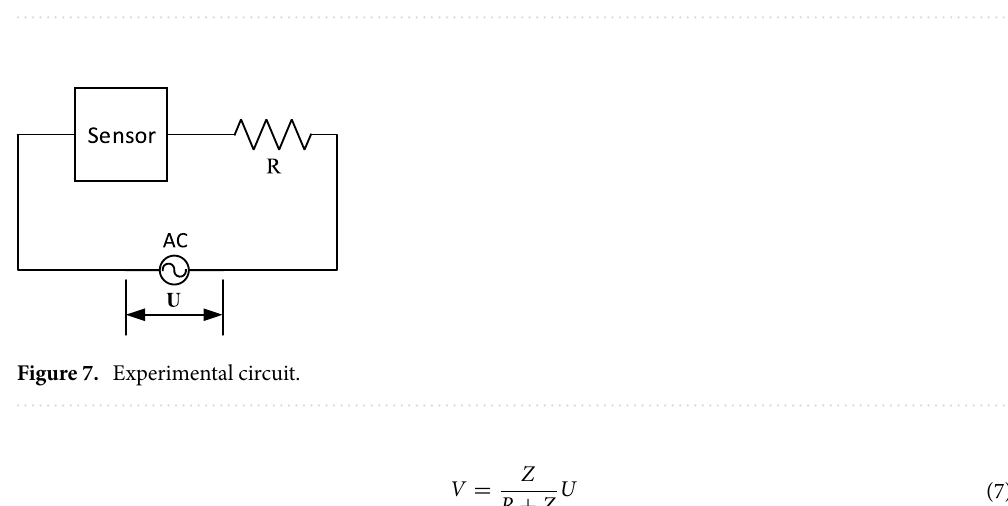
Figure 6. Top: schematic of the sensor. Bottom: appearance view of the sensor (left) and SEM micrograph of the fractal electrode (right).